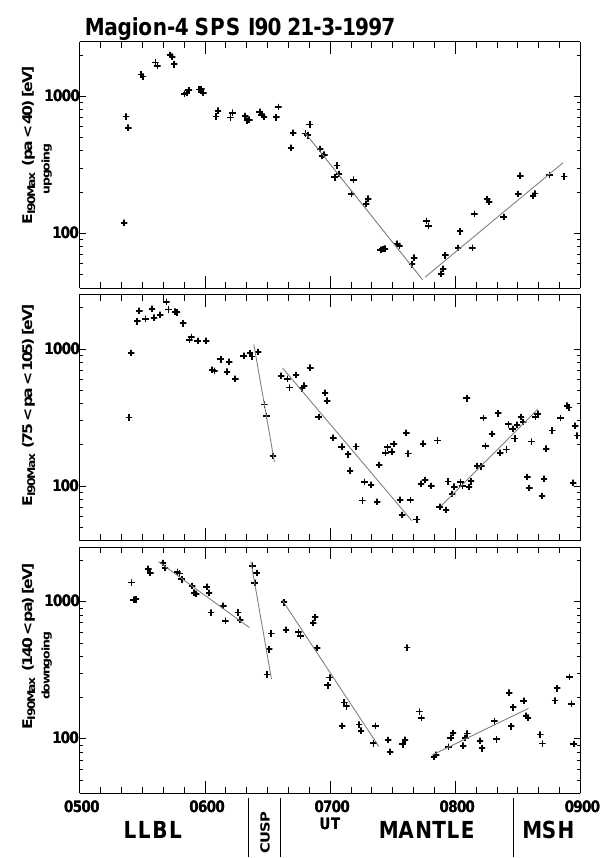
Fig. 4. The maxima of differencial energy fluxes in different direc- tions with respect to the magnetic